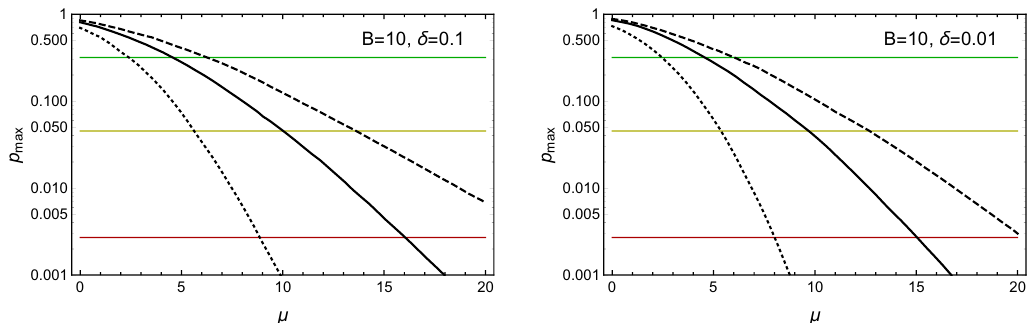
Figure 5 . The expected p -value, computed at the median over 1000 toy Monte Carlos, for B = 10, (cid:14) = 0 : 1 (left) and (cid:14) = 0 : 01 (right). Continuos, dashed and dotted lines represent the full, the (cid:31) 2 and the modi(cid:12)ed (cid:31) 2 tests, respectively. The levels of p -value corresponding to 1, 2 and 3 (cid:27) are also